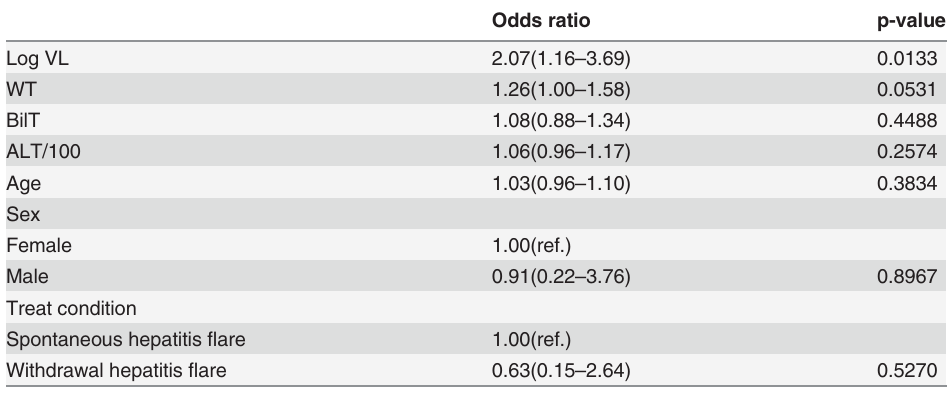
Table 5. The multiple logistic regression analysis for variables between group 1 and 2.